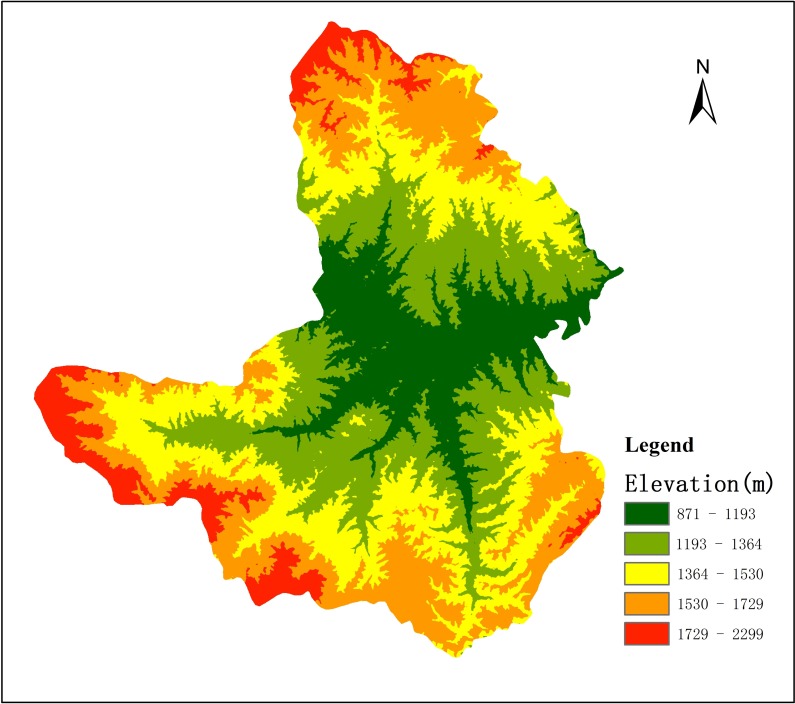
The DEM of Gujiao.